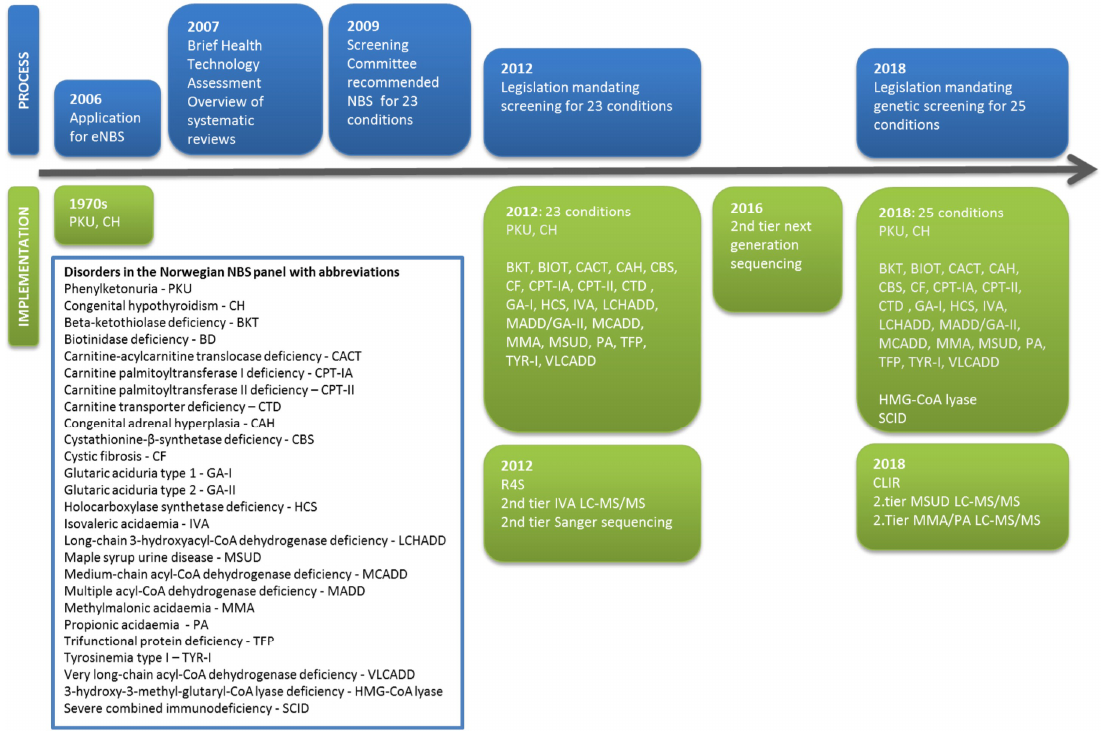
Figure 1. Timeline for the development of newborn screening (NBS) in Norway, showing the administrative and legislative process (blue) alongside the inclusion of new disorders and the implementation of new screening methods